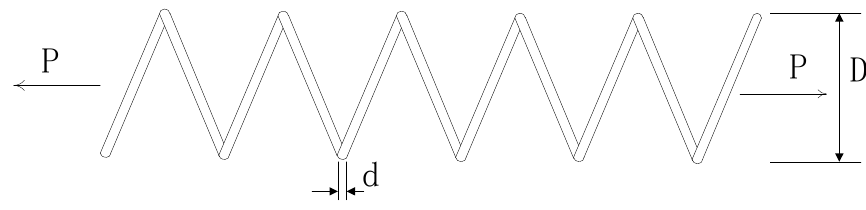
Figure 15. Spring design.